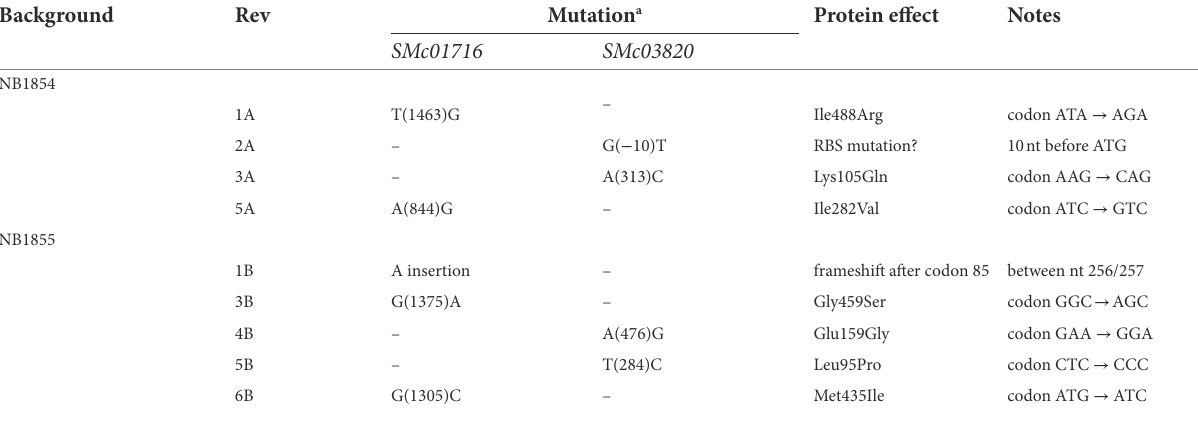
TABLE 2 Unique mutations detected in salt-resistant ∆ srlA phenotypic revertant